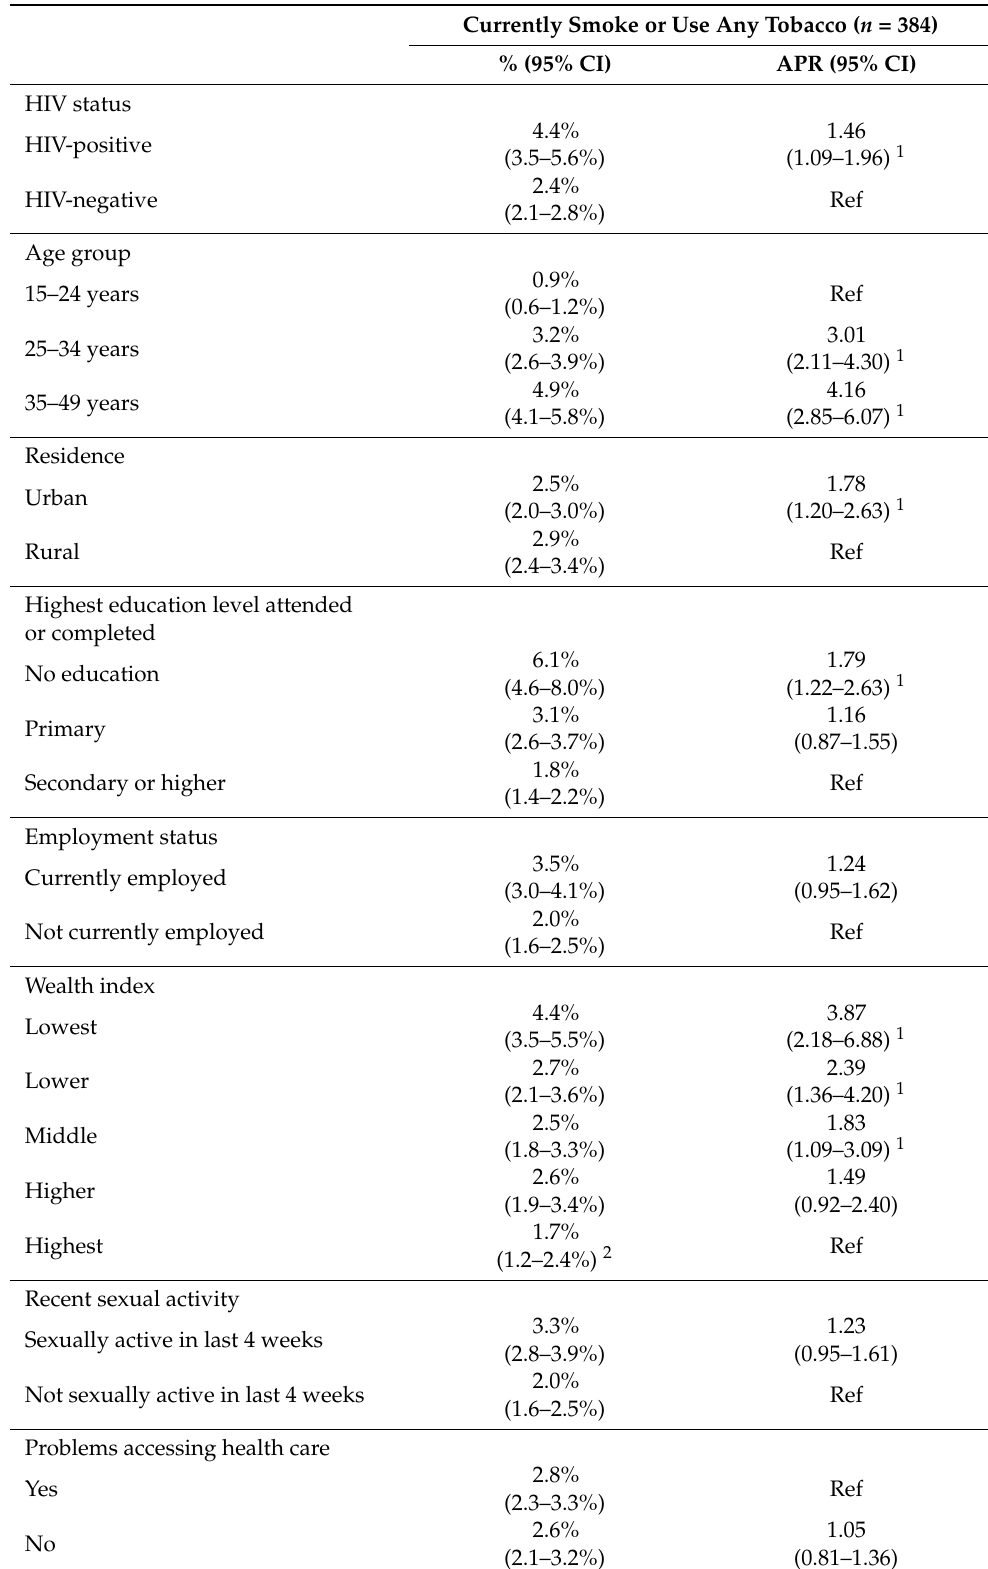
Table 3. Prevalence and adjusted prevalence ratios (APRs) for HIV status and selected characteristics with any current tobacco use among women—2018 DHS,